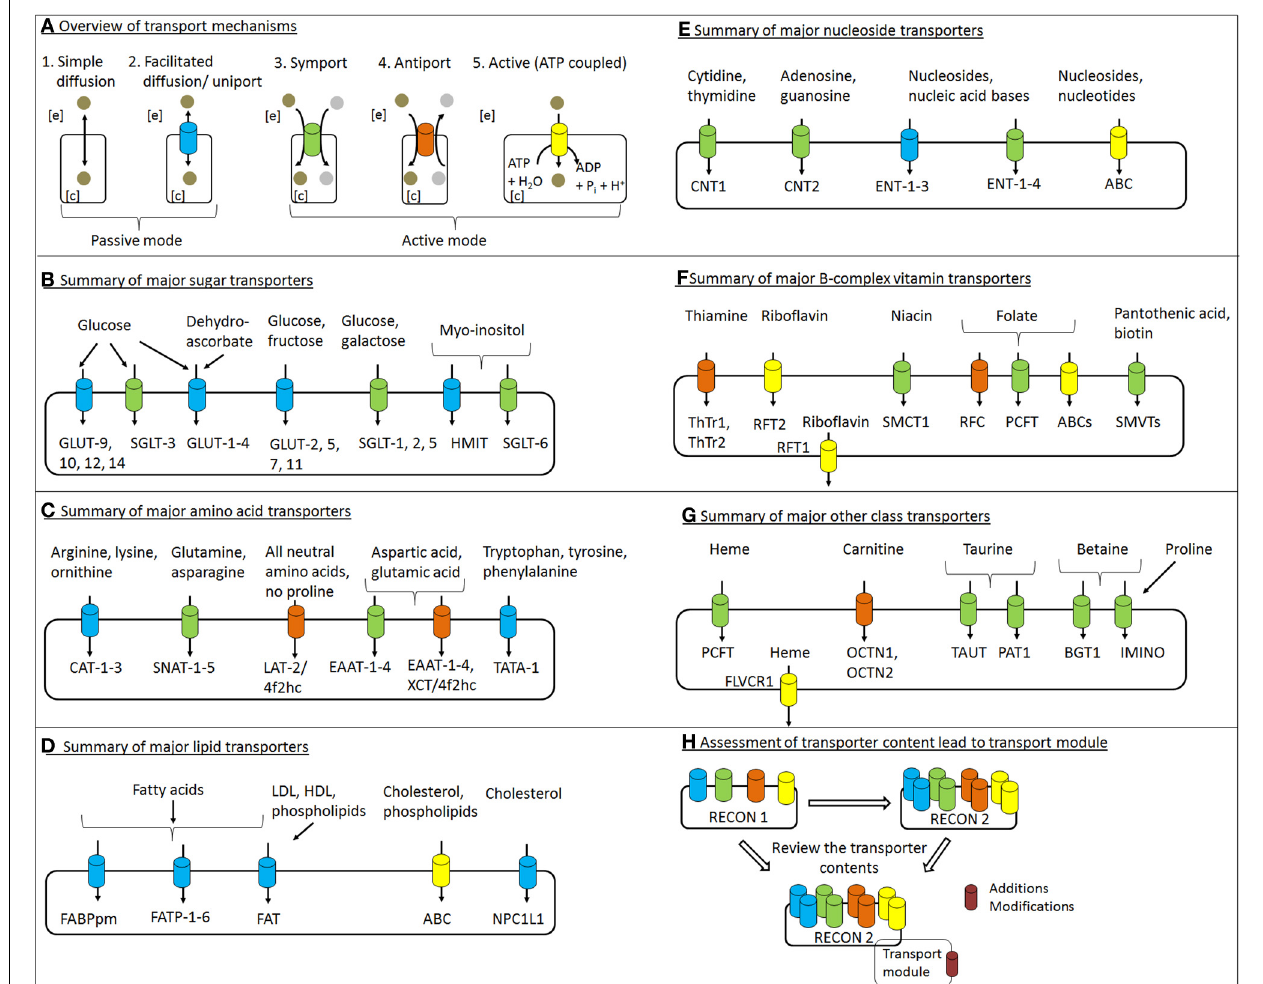
FIGURE 1 | Overview of transport mechanisms and major transport proteins of the various metabolite classes. (A) The basic modes for metabolite transport across the plasma membrane are shown. Based on the energy association, transport processes can be categorized into active and passive modes based on the energy used. The active mode can be further classified into primary and secondary mechanisms, while the metabolites can also be transported mainly via simple diffusion or facilitated diffusion driven by an increase in entropy. Specialized transport mechanisms (e.g., receptor-mediated endocytosis and tertiary active processes) are not shown. (B–G) . Highlights major transport proteins